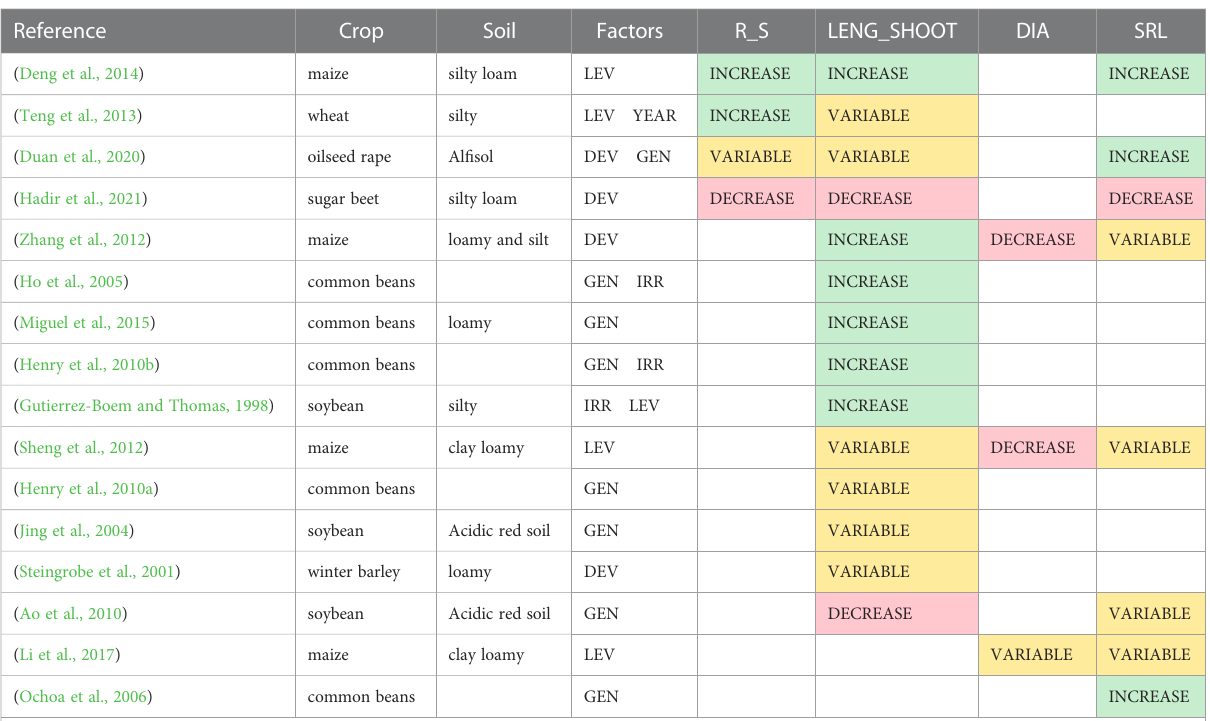
TABLE 7 Studies that report effects of P de fi ciency on the root-to-shoot ratio (R_S), root length per shoot biomass (LEGN_SHOOT), root diameter (DIA) and speci fi c root length (SRL) at the fi eld